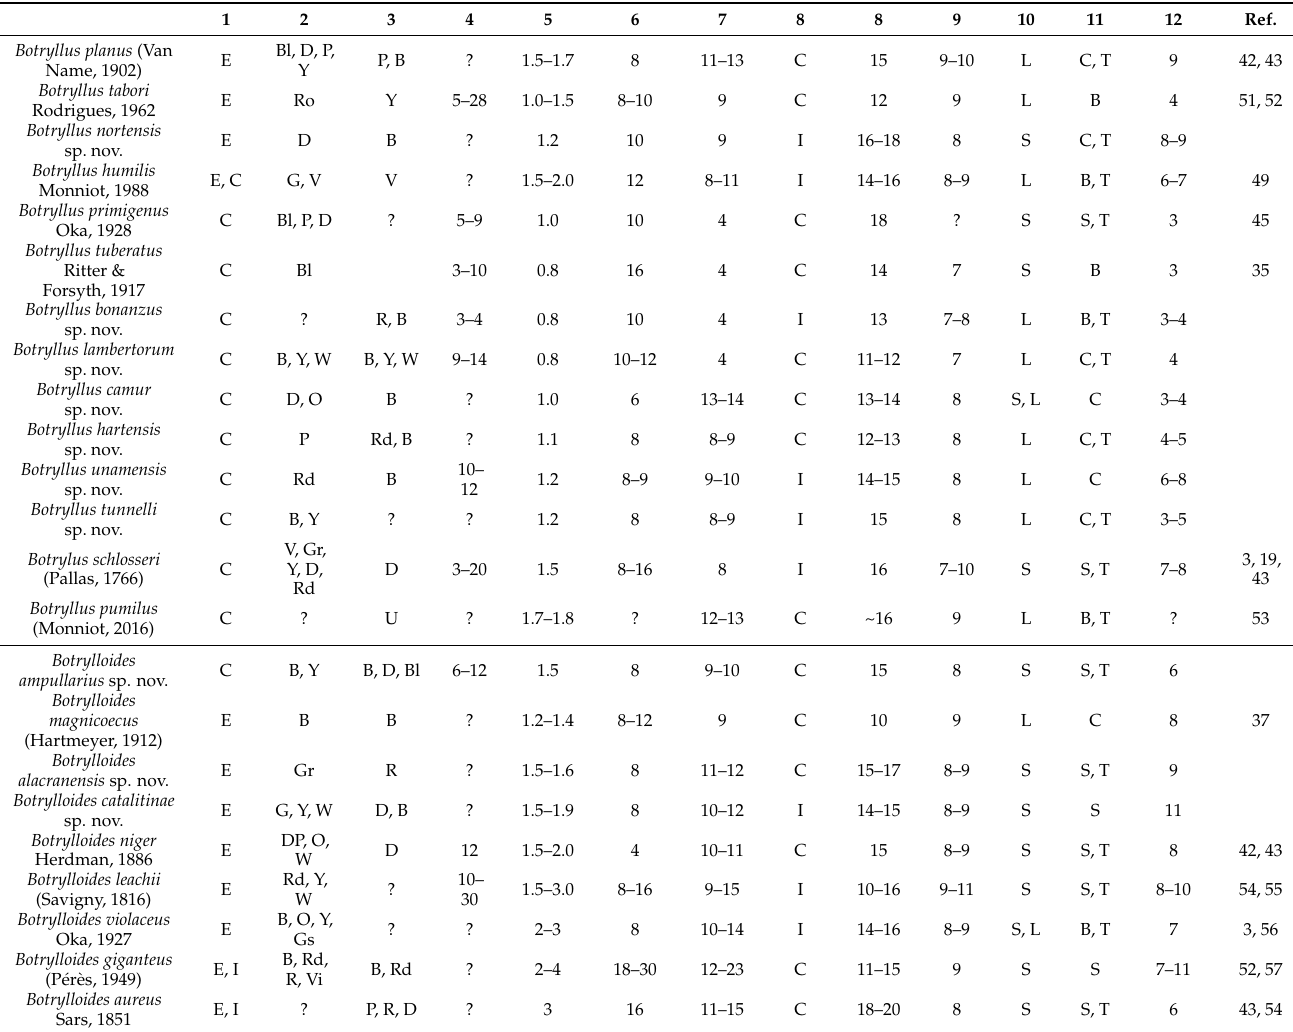
Table 1. Tabular identification key of Botryllus and Botrylloides species of the Atlantic